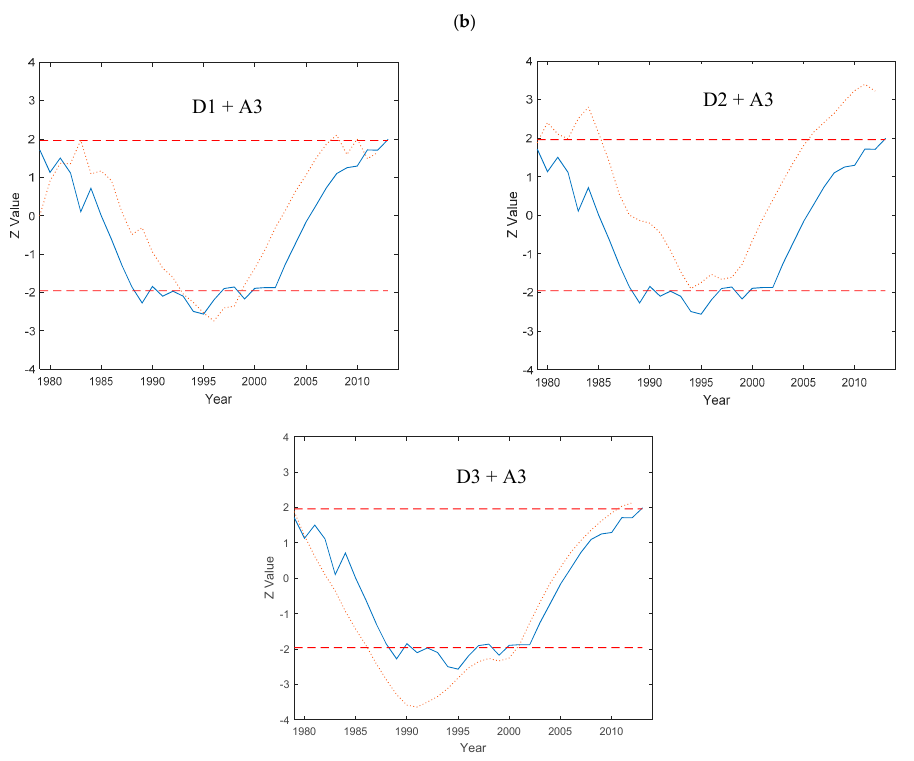
Figure 10. Sandusky River: ( a ) Continuous wavelet transform of daily soluble reactive phosphorus (SRP). ( b ) Plots of the sequential Mann–Kendall analyses on the Details (with added Approximation component) of the annual SRP data. The top and bottom dashed lines are ±1.96, which are the confidence limits of the MK test using α = 5%. The solid and dotted lines show the sequential MK values for the original data and the Detail components, respectively. For this SRP data, the D3 (8 years) component was the most dominant periodicity for this trend.